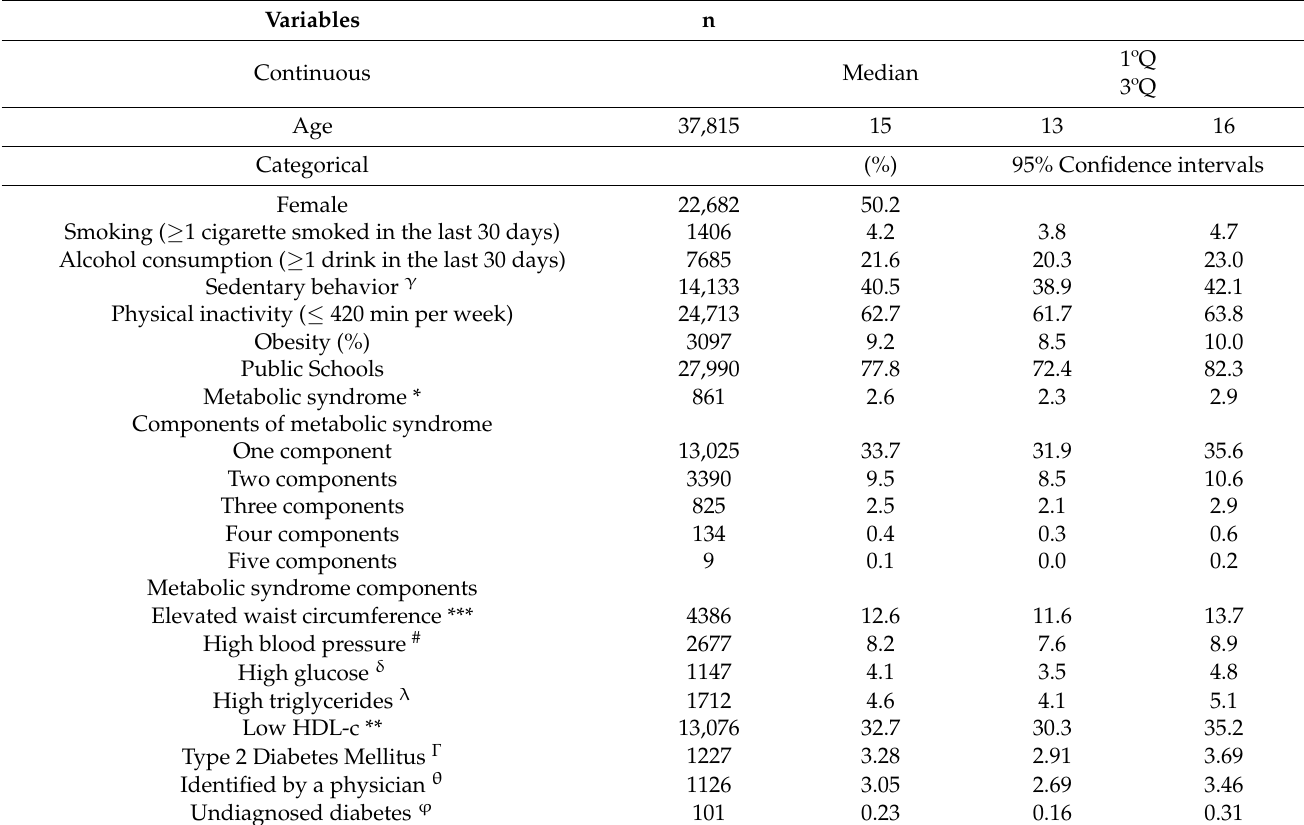
Table 1. Characteristics of 37,815 study participants in the Study of Cardiovascular Risk Factors in Adolescents (ERICA,